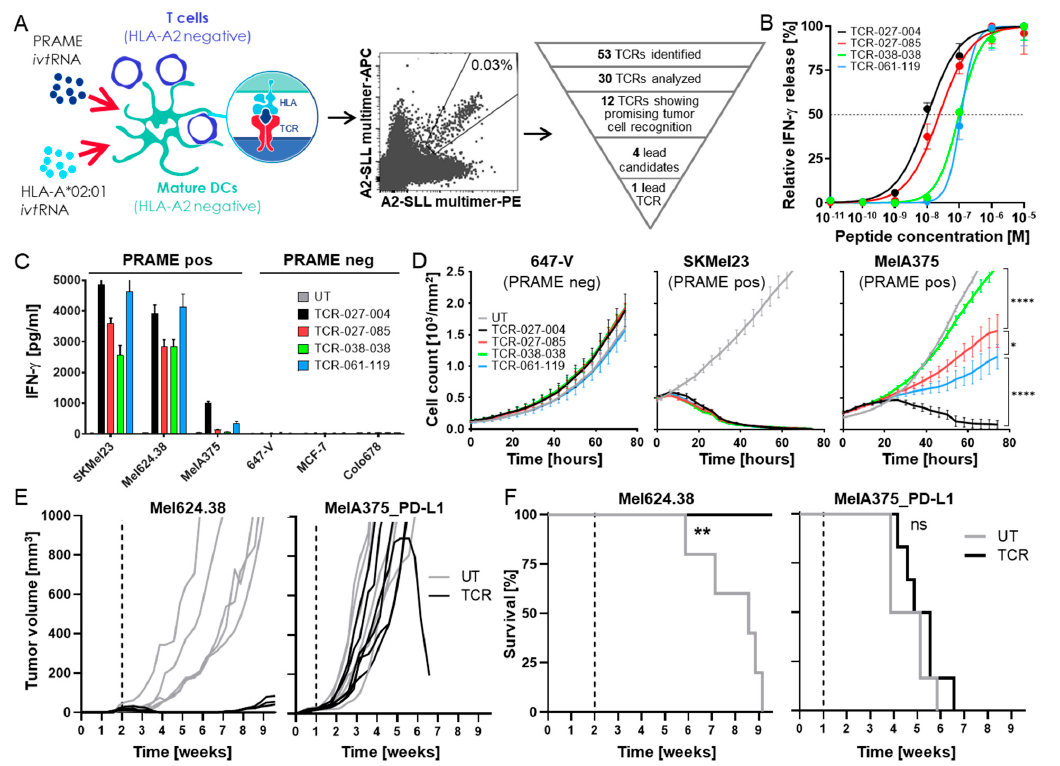
Figure 1. Isolation and selection of a lead PRAME-SLL-TCR from a non-tolerized T-cell repertoire. ( A ) CD8+ T-cells from HLA-A*02-negative healthy donors were stimulated using autologous monocyte-derived mature dendritic cells (mDCs) transfected with ivtRNA encoding PRAME and HLA-A*02:01. Dot blot shows staining with PE ( x -axis) and APC ( y -axis) labeled PRAME-multimers used for single-cell FACS. Percentage of double-positive cells is indicated. Promising TCRs were reconstructed and transferred into effector CD8+ recipient T-cells by retroviral transduction. Based on multi-parameter screening (triage process), four promising TCR candidates (TCR-027-004, TCR-027-085, TCR-038-038, and TCR-061-119) were selected from more than 30 analyzed specific TCRs. ( B ) Functional avidity of TCR-transgenic T-cells was analyzed in co-cultures with peptide-loaded T2 cells. Cells were cultured at an E:T ratio of 1:1. The graph shows nonlinear regression curves of relative IFN- γ values. Half maximal IFN- γ secretion is indicated by the dashed line at 50%. The data represent the means of duplicates measured at each peptide concentration. ( C ) IFN- γ concentrations released by the different TCR-Ts after co-culture with HLA-A*02-positive tumor cell lines that were either PRAME-positive (SKMel23, Mel624.38 and MelA375) or PRAME-negative (647-V, MCF-7 and Colo678). Untransduced (UT) T-cells served as negative control. IFN- γ values are shown as the mean of duplicates. Cells were cultured at an E:T ratio of 4:1 except for 647-V cells, which were cultured at an E:T ratio of 8:1. ( D ) Cytotoxicity of TCR-Ts expressing different PRAME-TCRs against fluorescently labeled HLA-A*02-positive tumor cell lines (PRAME-negative: 647-V; PRAME-positive: SKMel23, MelA375), assessed using a live-cell imaging system (IncuCyte ® ZOOM, Sartorius). Loss of red fluorescence visualized tumor cell apoptosis. UT effectors served as negative control. Cells were cultured at an E:T ratio of 4:1 except for 647-V cells, which were cultured at an E:T ratio of 8:1. Mean of cell counts using triplicates are shown over time. Statistical significance was calculated with one-way ANOVA with multiple comparisons (* p < 0.03, ** p < 0.002, **** p < 0.0001). Experiments in ( B – D ) were repeated three times with T-cells derived from different donors; data from one representative donor are shown. ( E , F ) 5 × 10 6 Mel624.38 or MelA375_PD-L1 cells were injected s.c. into immunodeficient (NOD/Shi-scid/IL-2R γ null) mice. Mice were treated on day 14 for Mel624.38 and day 7 for MelA375_PD-L1, respectively, with T-cells expressing TCR-027-004 or UT T-cells (5–6 mice per group) and ( E ) tumor growth and ( F ) survival of mice was followed until day 67 after tumor cell injection. Statistical significance between UT and TCR was calculated using the log-rank Mantel–Cox test (Mel624.38 p = 0.0018 and MelA375_PD-L1 p =